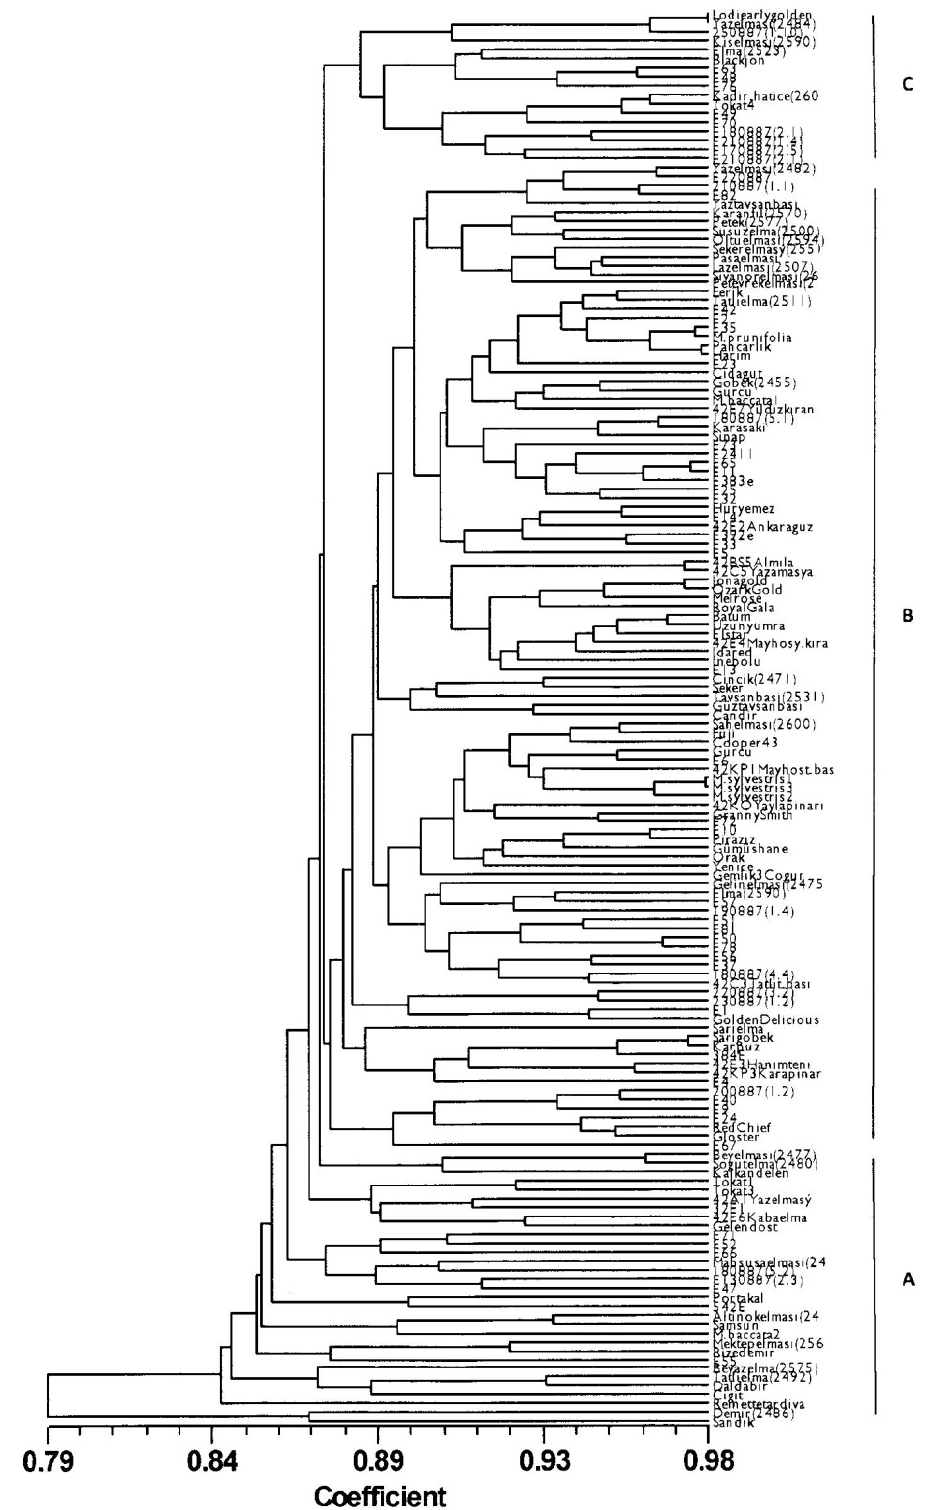
Fig 1: Dendrogram of 158 apple accessions based on the ISSR markers and the UPGMA method. understand genetic relationships. Fig. 2 presents the distribution of different genotypes according to two principal axes of variation using PCoA, which revealed the variation among the accessions si- milar to the UPGMA